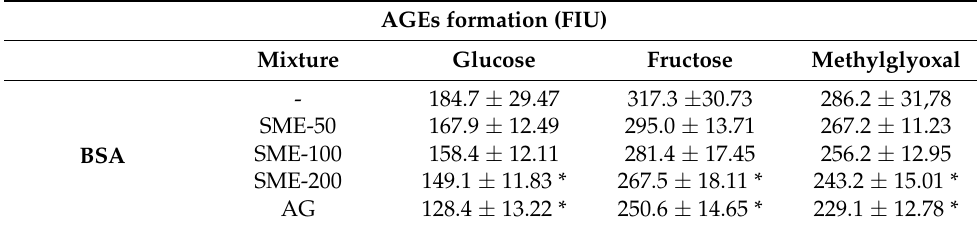
Table 1. The in vitro effects of spinach methanolic extract (SME) on BSA glycation. Aliquots of reaction mixtures were used to determine AGEs formation, fructosamine level, protein carbonyl, and thiol group